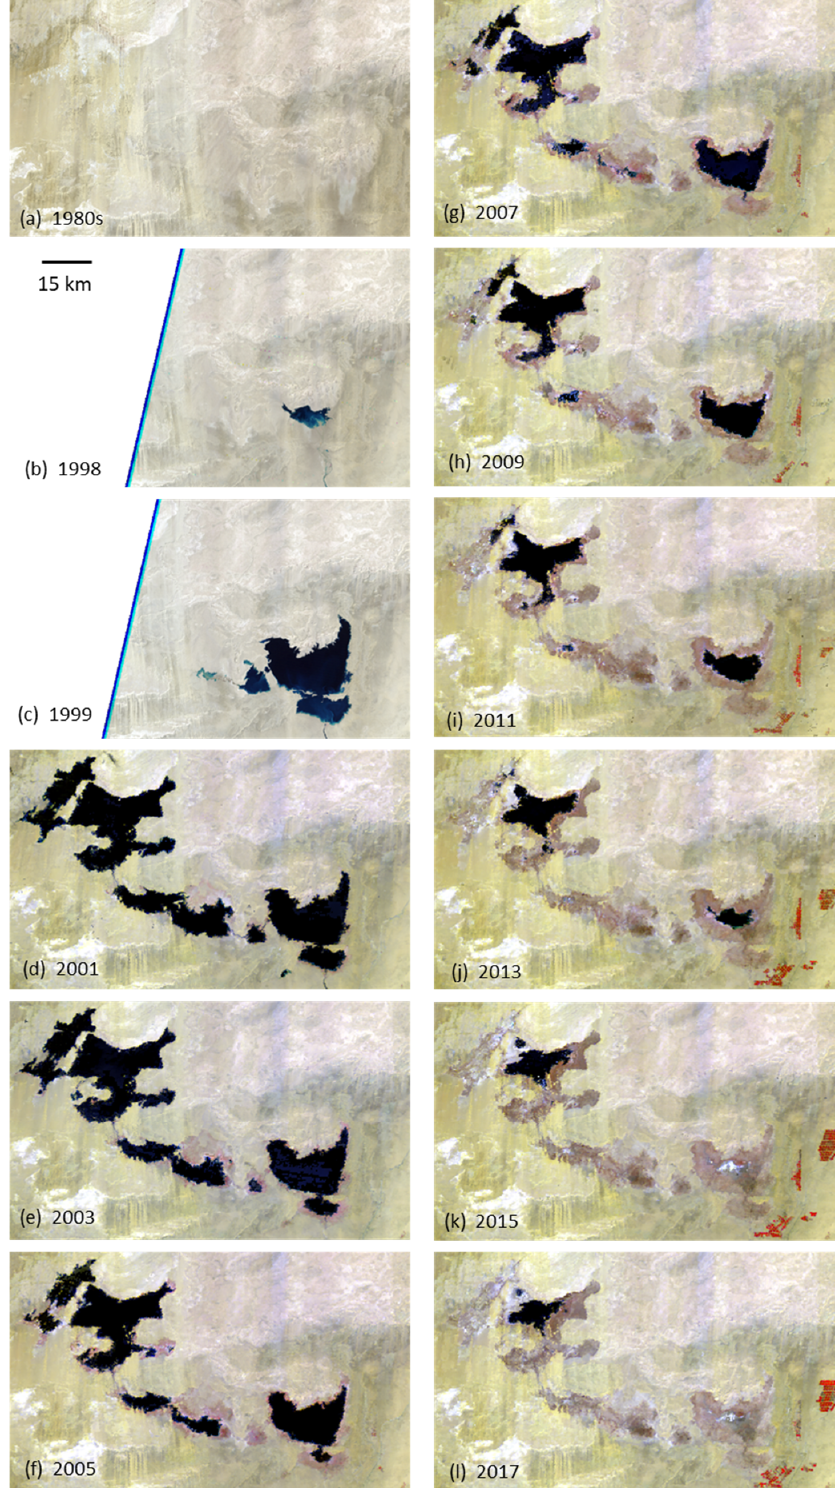
Figure 3. Formation, expansion, and desiccation of the Toshka Lakes. ( a ) Landsat image mosaic from